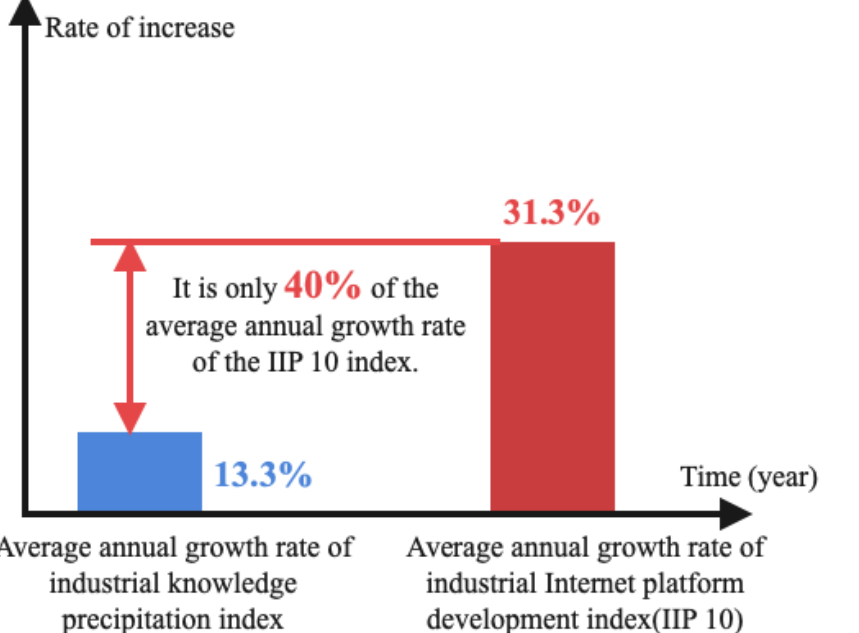
Figure 5. Growth trend of platform industrial knowledge accumulation index from 2018 to 2020.